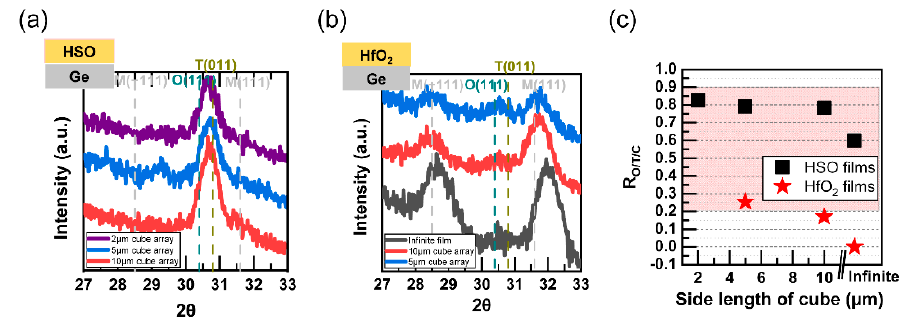
Figure 5. GIXRD results of ( a ) HSO (~4 mol% of Si) cuboid array films and ( b ) undoped HfO 2 cuboid array films. The peak] intensity of the O/T/C phase increases with the decrease of array size. ( c ) Extracted R O/T/C by fitting GIXRD results in ( a , b ). O-phase seems formable in undoped films only by decreasing the side length.